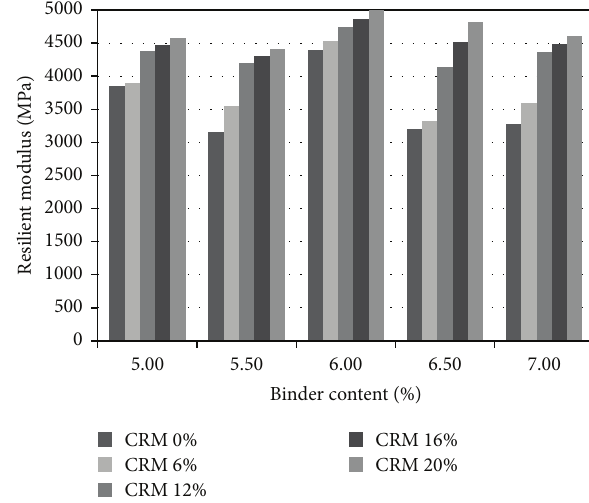
Figure 7: VIM results versus binder content.